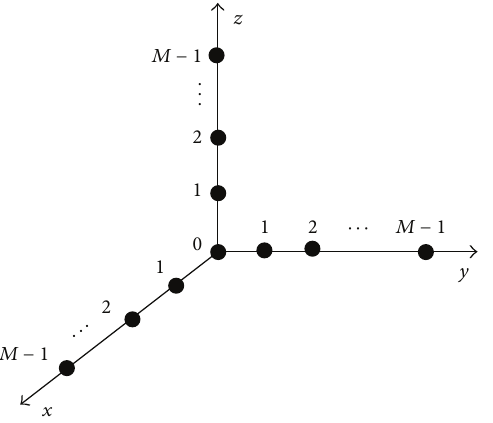
Figure 1: 2-L shape array consists of three